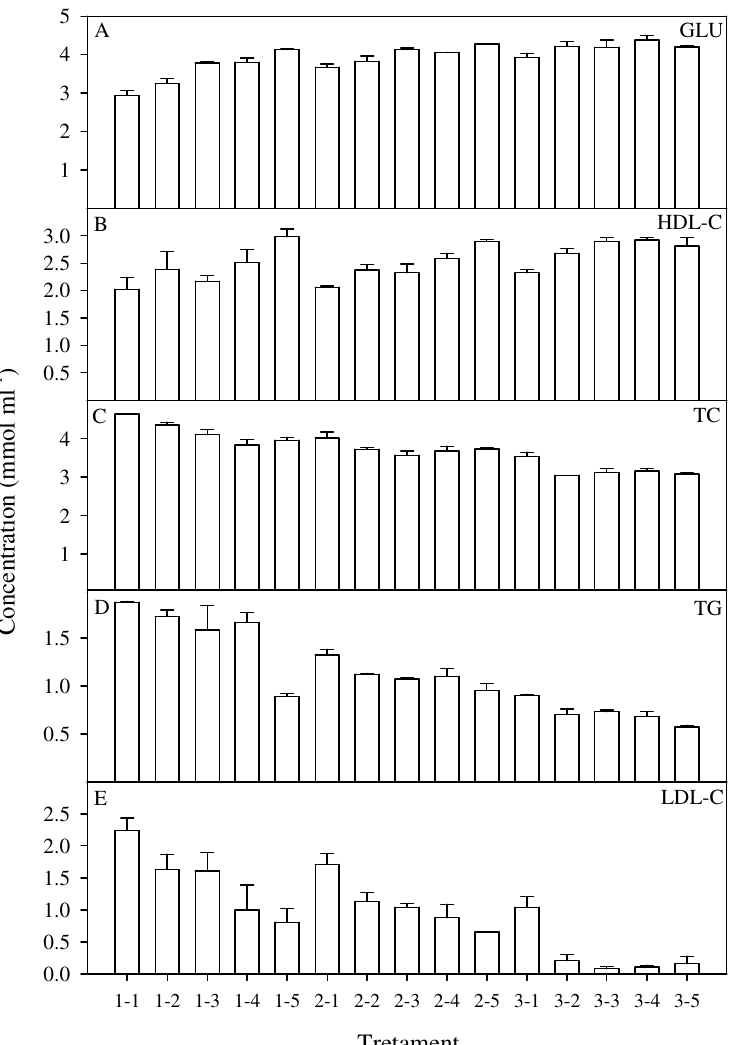
FIGURE 3 . Interactive effects of dietary protein L-carnitine levels on (A) GLU, (B) HDL- C, (C) TC, (D) TG, and (E) LDL-C of the new GIFT strain of juvenile Nile tilapia. Error bars represent one standard deviation of each treatment. X-axis label represents the levels of protein and L-carnitine